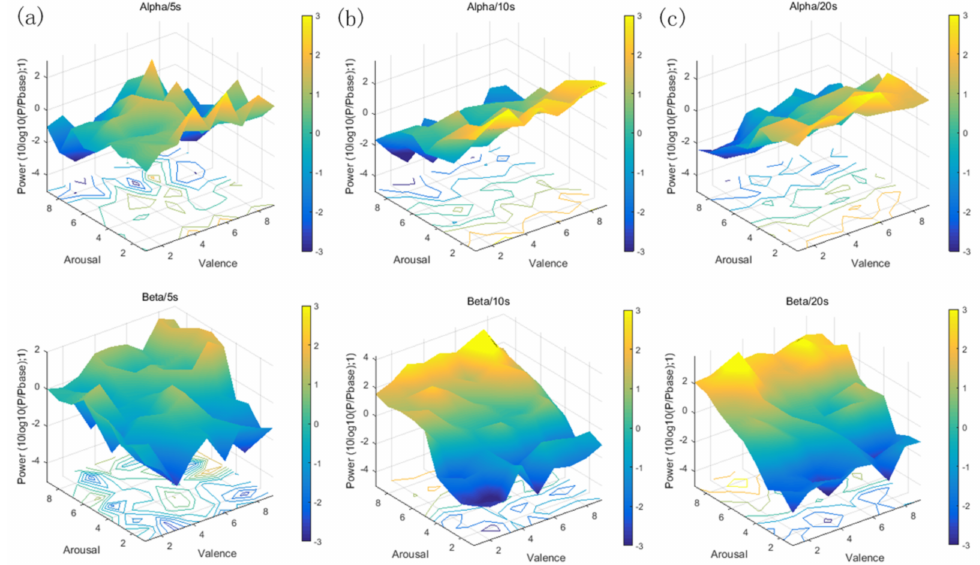
Figure 9. The variation trend of alpha and beta power, corresponding to different length of reconfigurable music segments: ( a ) The power change ratio of alpha and beta, corresponding to 5 s reconfigurable music segment (10 × log10(P/Pbase)); ( b ) the power change ratio of alpha and beta, corresponding to 10 s reconfigurable music segment (10 × log10(P/Pbase)); and ( c ) the power change ratio of alpha and beta, corresponding to 20 s reconfigurable music segment (10 ×